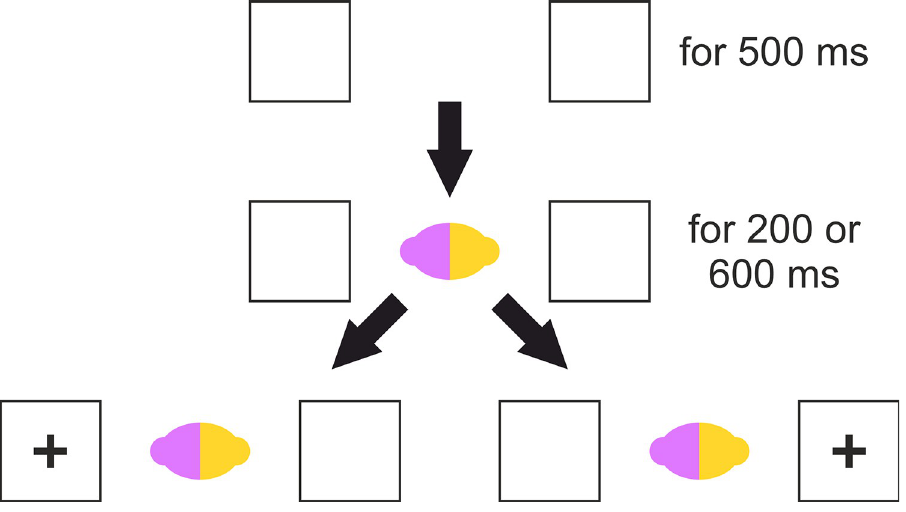
Fig 15. Schematic representation of a trial in Experiment